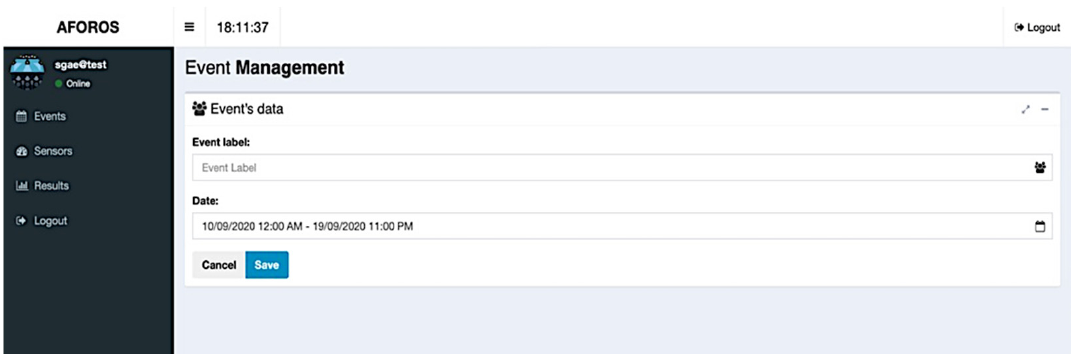
Figure 8. Events edit form in the web application.